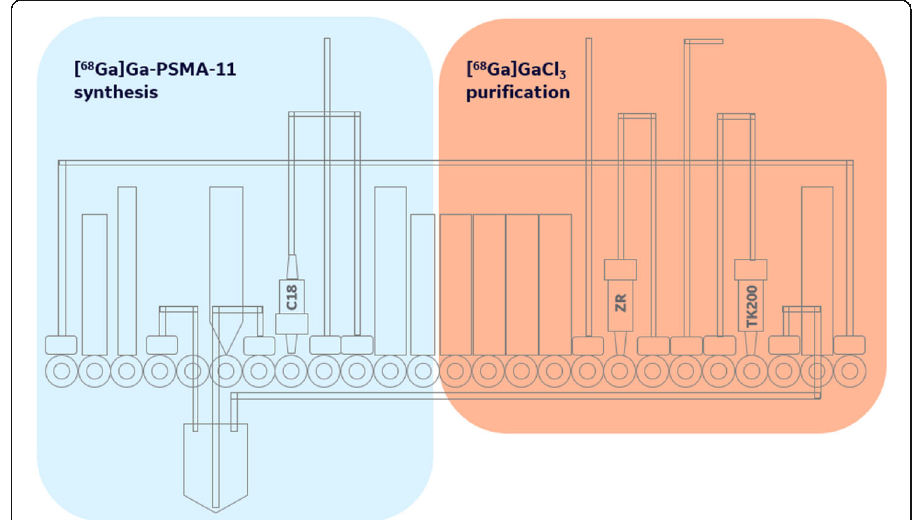
Fig. 6 Partitioning of FASTlab cassette: Right-hand side is reserved for [ 68 Ga]GaCl 3 purification, and the